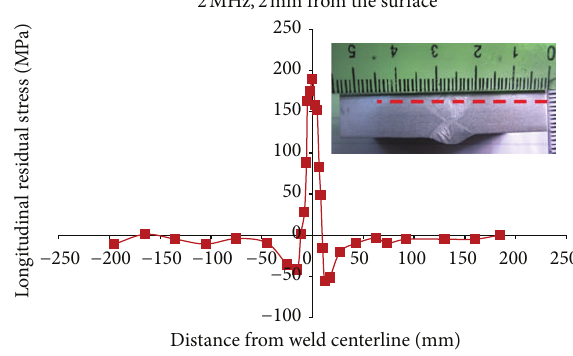
Figure 7: Result of tensile test to evaluate acoustoelastic constant.